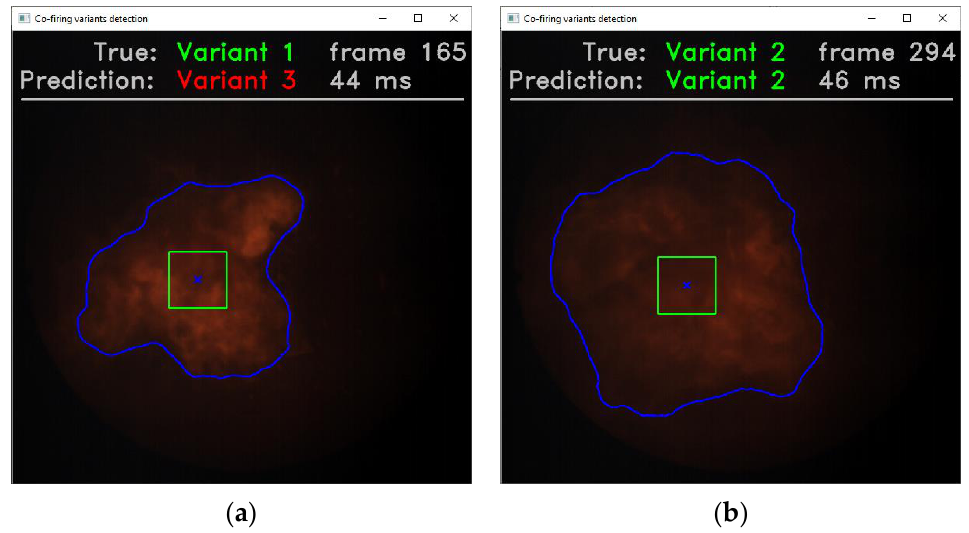
Figure 12. Application interface for testing the method of identifying co-firing variants: ( a ) an example of incorrect classification; ( b ) an example of correct classification. At the top, the following information is displayed: actual label of the currently displayed variant (green color), below—a label of the variant recognized by the classifier (green color—correct classification, red—incorrect), to the right—current image frame number, below—the frame processing time, including the time of the ROI extraction and the co-firing variant prediction time using the constructed model. In the central part, the contour of a flame and its centroid (blue cross) are marked as well as the ROI (green square), the center of which is in the contour’s centroid.